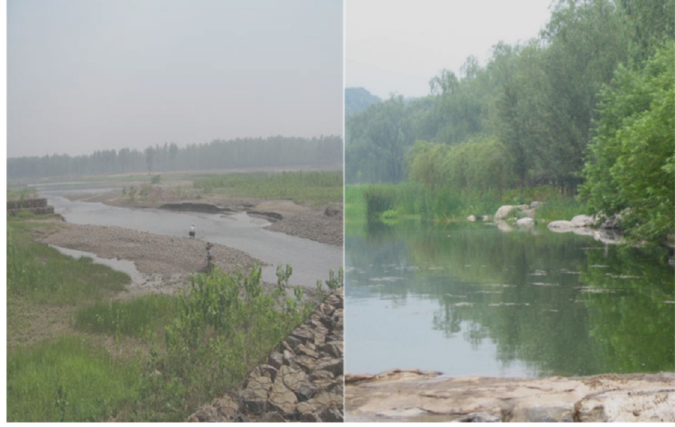
Figure 16. Wetland restoration and renovation project in the sandy wasteland area.